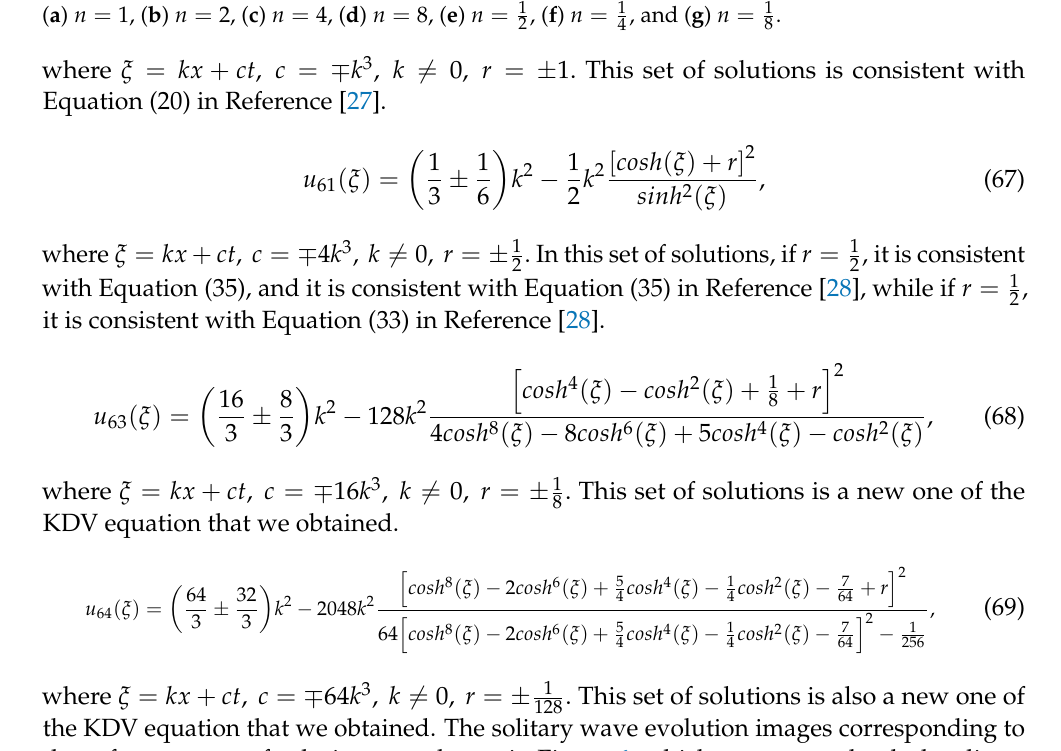
, ( f ) n = 1 , and ( g ) n = 1 2 8 4 , ( f ) 𝑛 = (cid:2869) , and ( g ) 𝑛 = (cid:2869) . (cid:2870) (cid:2872) (cid:2876)